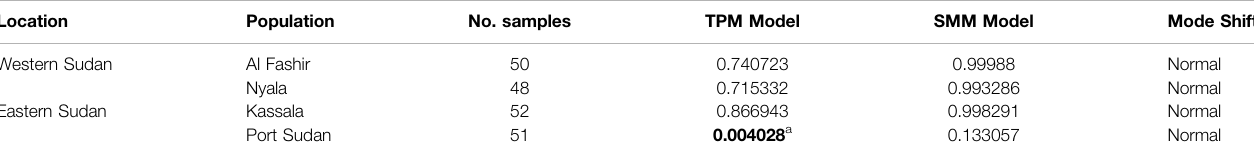
TABLE 4 | Bottleneck analysis. Wilcoxon signed-rank tests for heterozygosity excess and mode shift under the two-phase mutation model (TPM) and stepwise mutation model (SMM). Statistically signi fi cant deviation from equilibrium is present if the value is > 0.05.